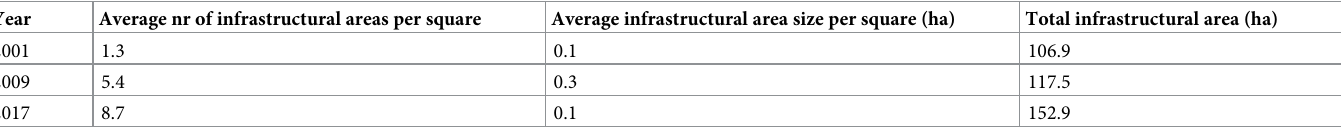
vineyard, water body and windmill at the rough habitat scale. Table 2. Change of present infrastructure for the years 2001, 2009, and 2017. Year Average nr of infrastructural areas per